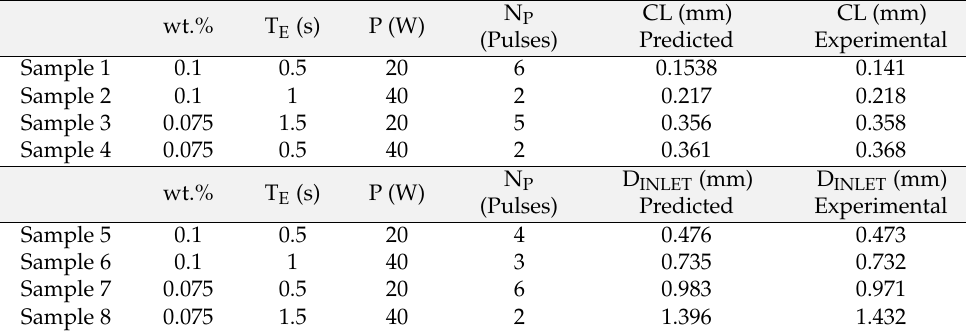
Table 1. ANOVA models validation: predicted and experimental response values for different combinations of process control parameters.